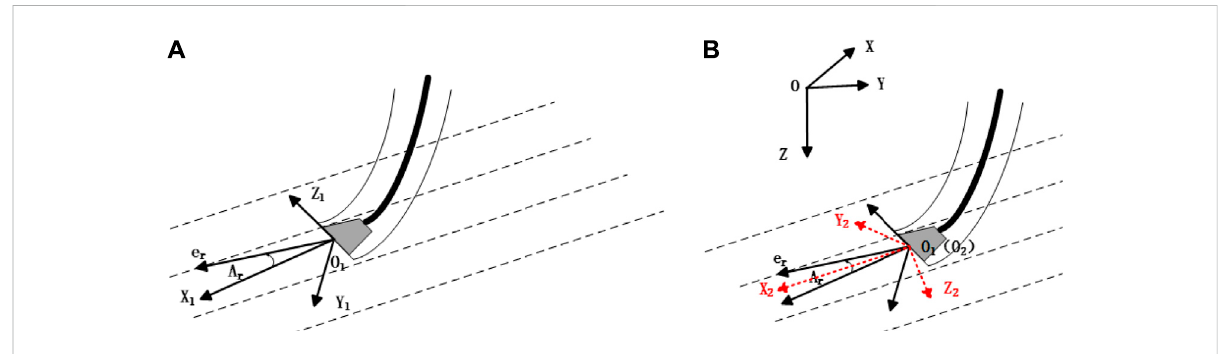
FIGURE 2 Schematic of bit advancement trend in formation and three coordinate systems (A) bit advancement trend in formation (B) three coordinate